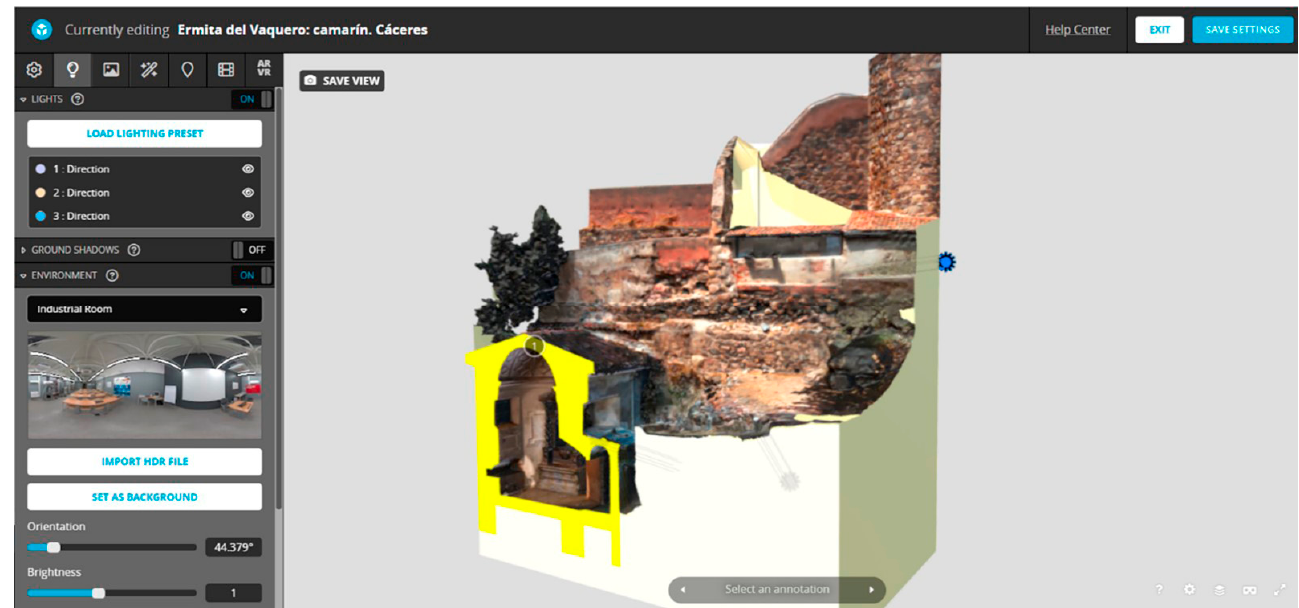
Figure 15. Sketchfab interface. Setting up illumination.